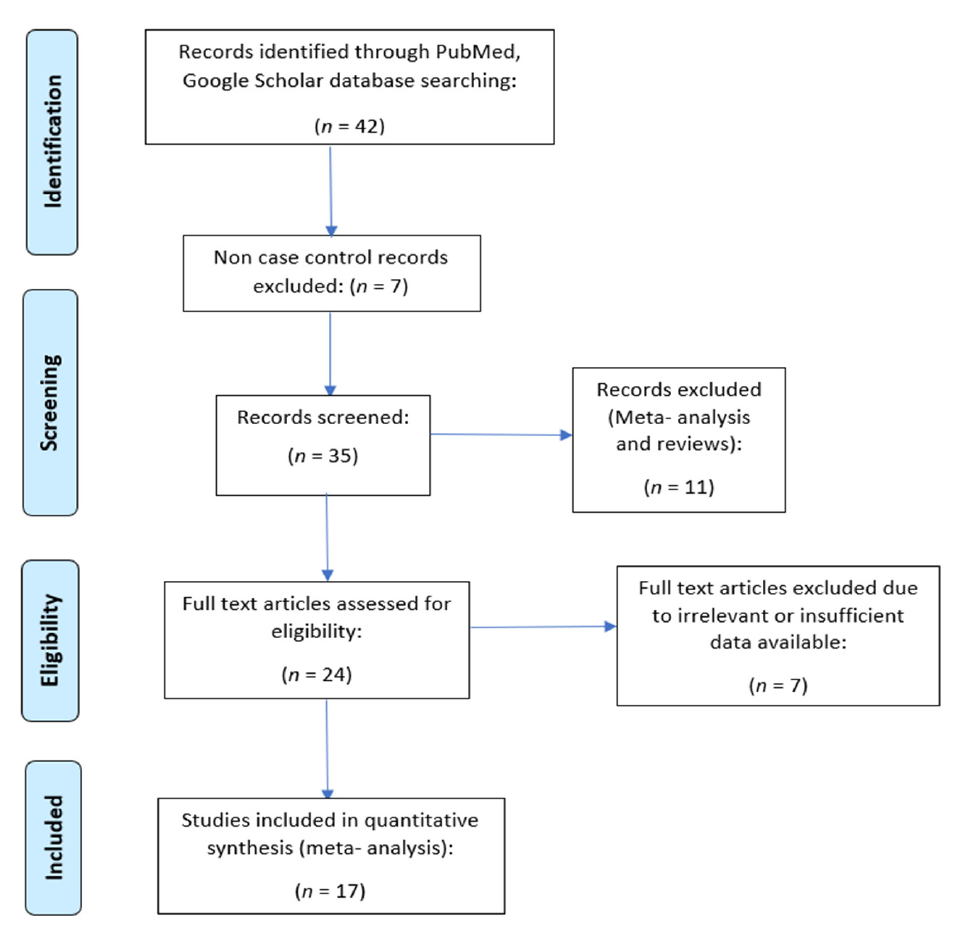
Figure 1. Prisma flowchart depicting the studies selected.